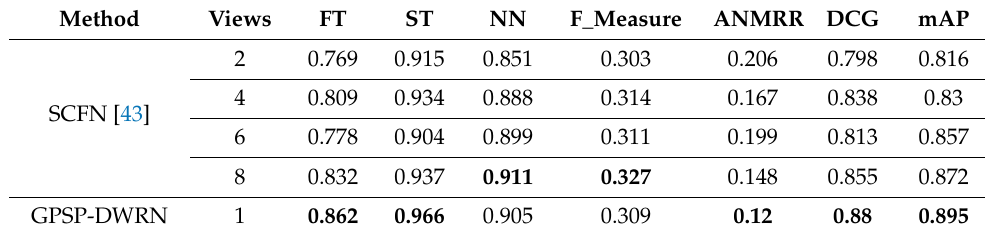
Table 3. Retrieval performance—ModelNet10. Bolding shows the maximum value in each column. Method